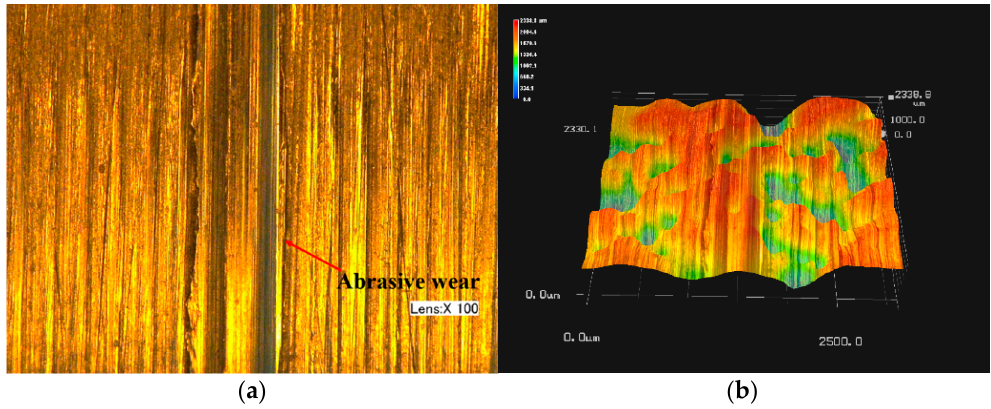
Figure 11. Micrographs of the fourth specimen: ( a ) 2D micrographs; ( b ) 3D micrographs.